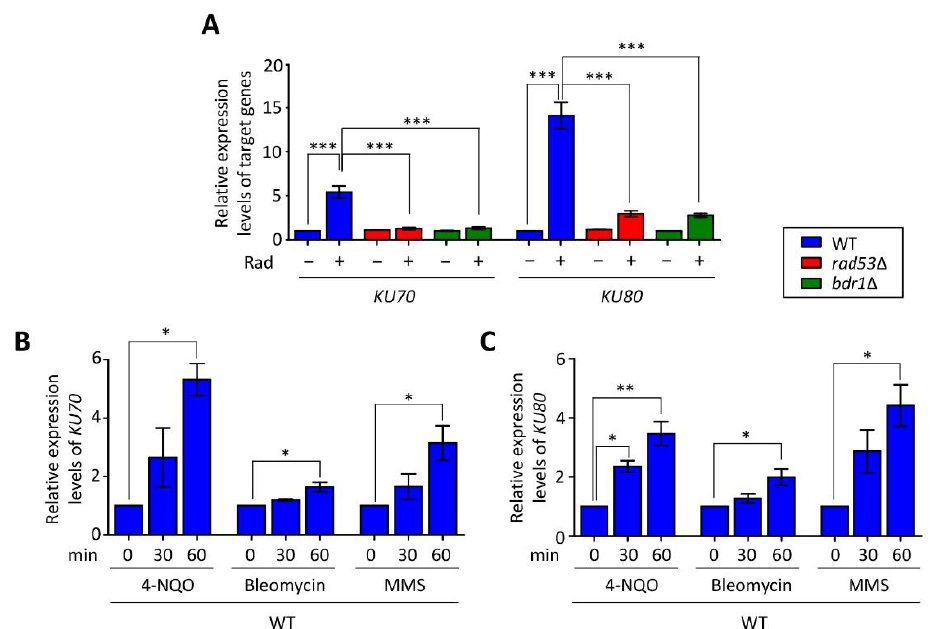
Figure 1. Expression levels of KU70 and KU80 in response to genotoxic stress. ( A ) Expressions of KU70 and KU80 were regulated by the Rad53 – Bdr1 pathway. Real-time quantitative PCR (qRT-PCR) analysis using cDNA synthesized from total RNA isolated from wild-type (WT) strain, rad53 ∆ , and bdr1 ∆ mutants with or without gamma radiation exposure. ( B , C ) Expressions of KU70 and KU80 were gradually increased in the 4-NQO, bleomycin, and MMS treatments in the WT. Total RNA was isolated from the WT strain treated with the indicated concentration of 4-NQO (0.1 µ g/mL), bleomycin (2 µ g/mL), and MMS (0.02%) for 1 h, and cDNA was synthesized from these total RNA samples. Three independent biological experiments with duplicate technical replicates were performed. Statistical significance of difference was determined by one-way analysis of variance (ANOVA) with Bonferroni’s test. Error bars indicate standard errors of means (* p < 0.05, ** p < 0.01, and *** p < 0.001).